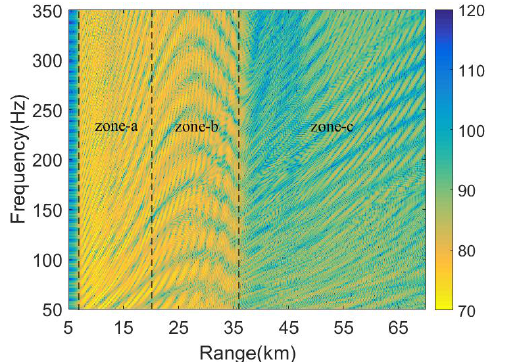
Figure 2. Intensity versus range and frequency. The intensity is divided into three parts, such as zone-a, zone-b, and zone-c, according to artificial